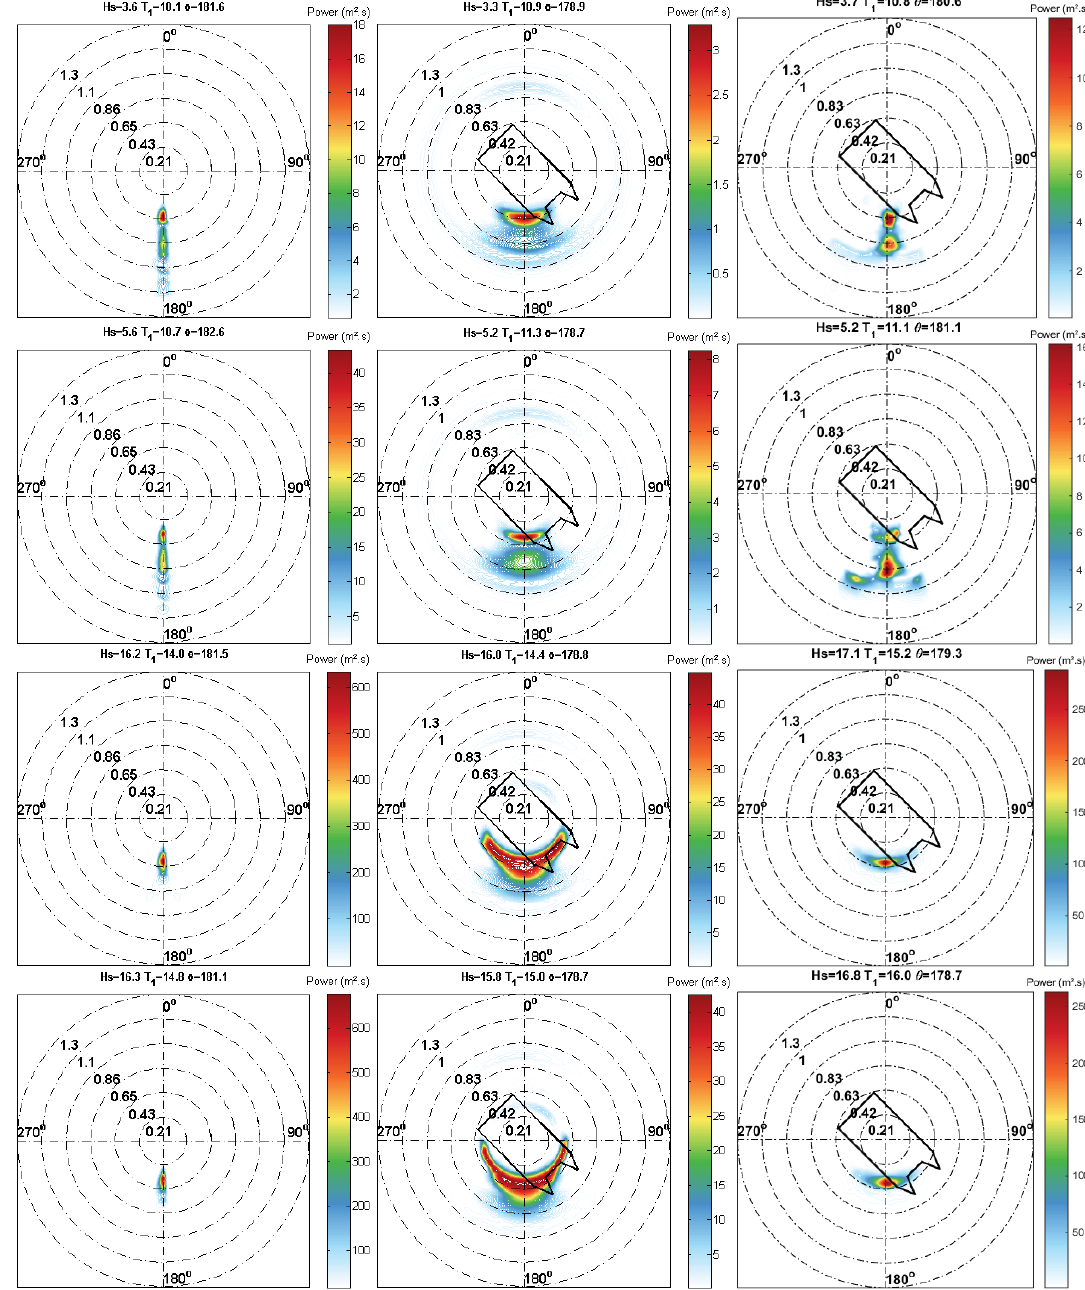
Figure 11. Directional wave spectra for a platform heading equal to 135 deg., estimated using three different methods. From left-to-right: Measured sea spectrum (MEM), the ones estimated with the conventional prior distribution and the output obtained with the alternative approach. From top-to-bottom: Sea conditions as provided Table